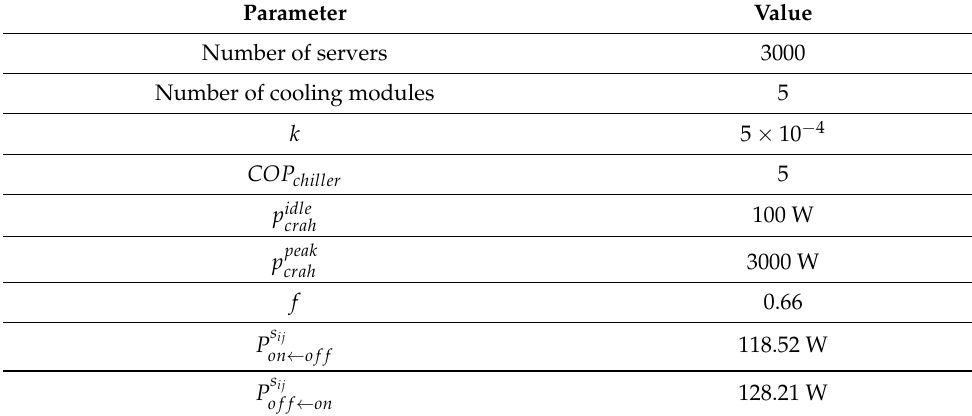
Table 1. Experimental